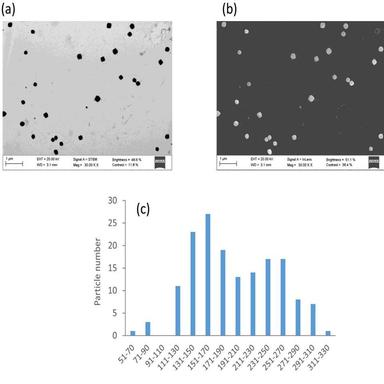
FESEM imaging of loaded NPs. (a) Image with STEM detector; (b) Image with InLens detector; (c) Size distribution obtained by Image J data treatment.